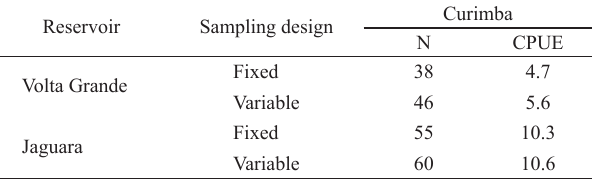
Fig. 2. Catch per unit effort (CPUE) of curimba for fixed and variable sampling sites by zone of Volta Grande (VGR) and Jaguara (JR) reservoirs. Tab. 1. Catch per unit effort (CPUE) of curimba by sam- pling design in Volta Grande and Jaguara